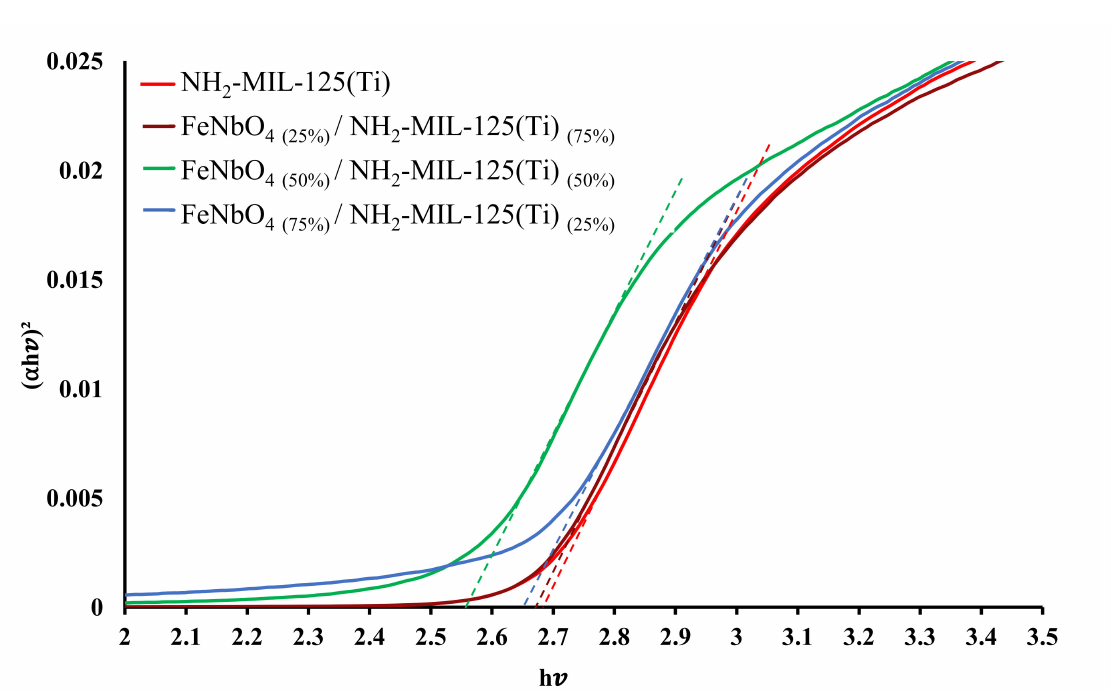
Figure 3. Tauc plot of FeNbO 4 and NH 2 -MIL-125(Ti) and the prepared